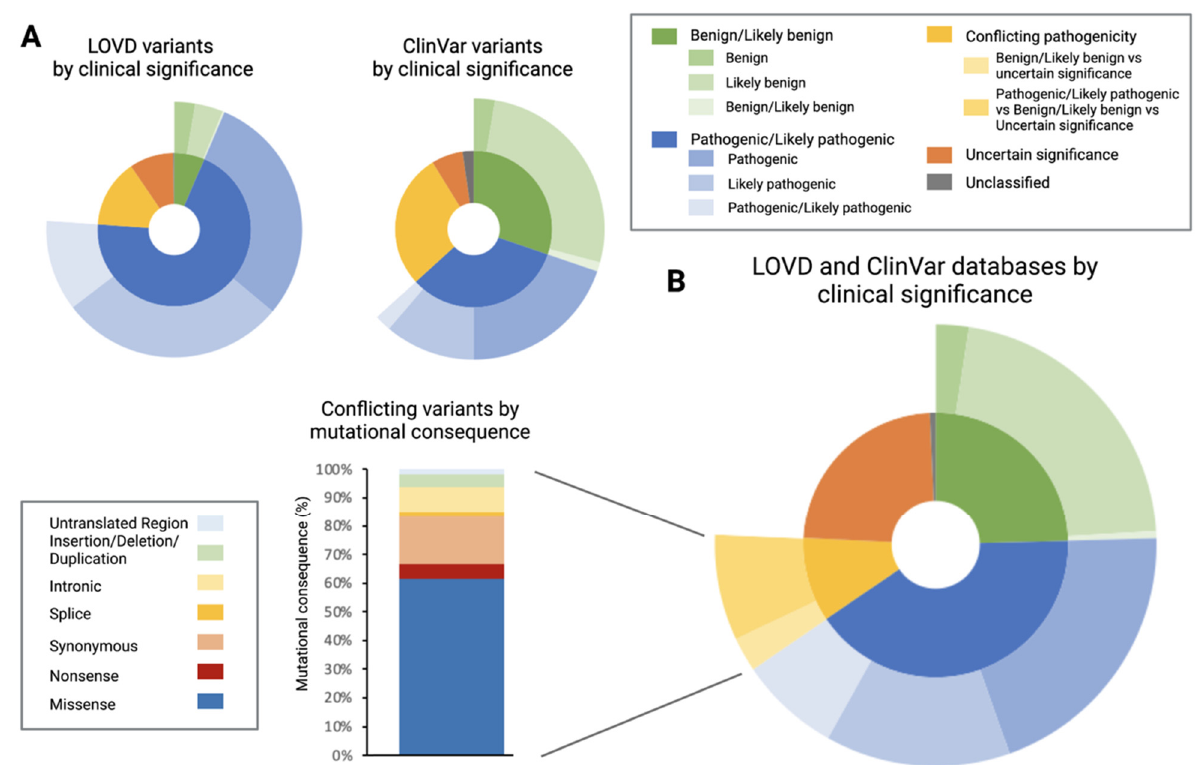
Figure 3. Breakdown of variants found in the Leiden open-source variation database (LOVD) and ClinVar database. ( A ) The ClinVar database exhibited a much higher proportion of benign/likely benign variants. ( B ) When the two datasets were merged, 41% were pathogenic/likely pathogenic variants and 11% were labelled as conflicting (reported on three levels of pathogenicity). Of the conflicting variants, over 60% were missense and almost 20% were synonymous variants.